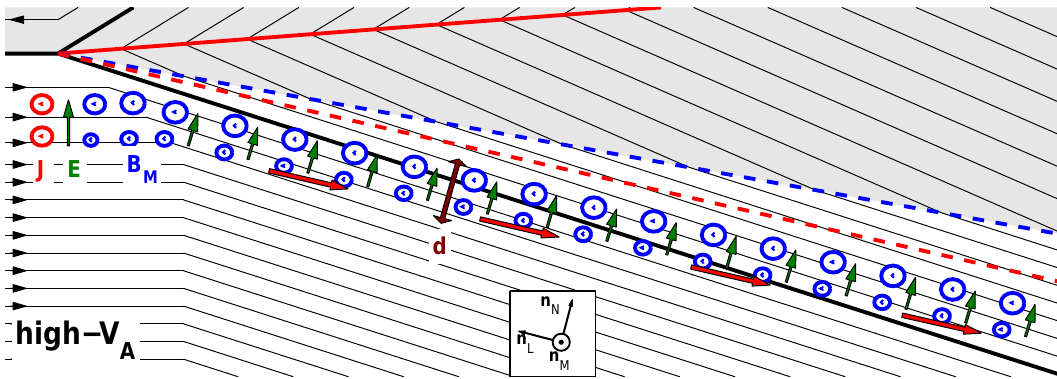
Fig. 2. Sketch showing the generation of an Alfv´en wave. The mechanism is described in the